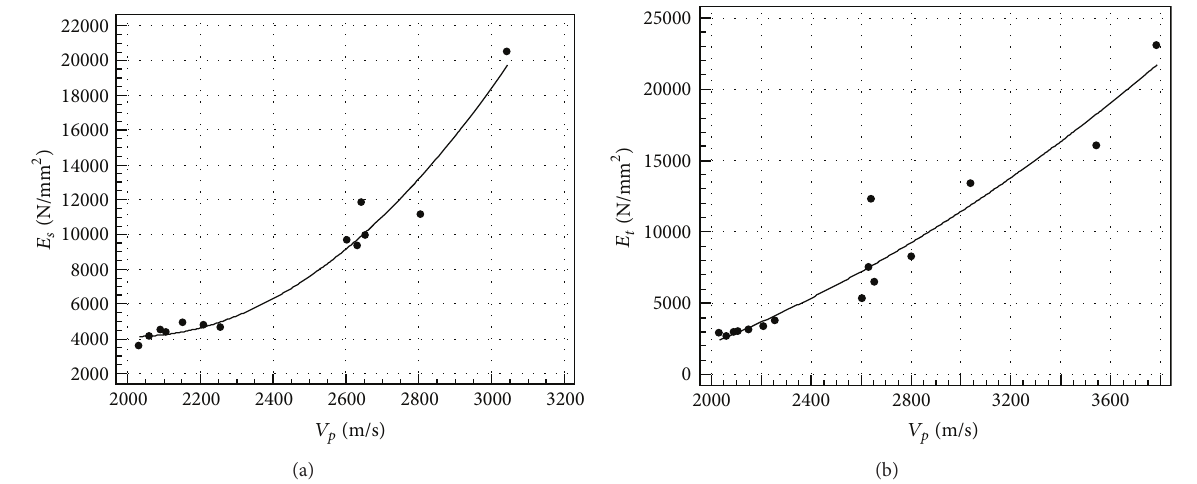
Figure 6: Regression between ultrasonic velocity and secant (a) and tangent (b) elastic modulus.